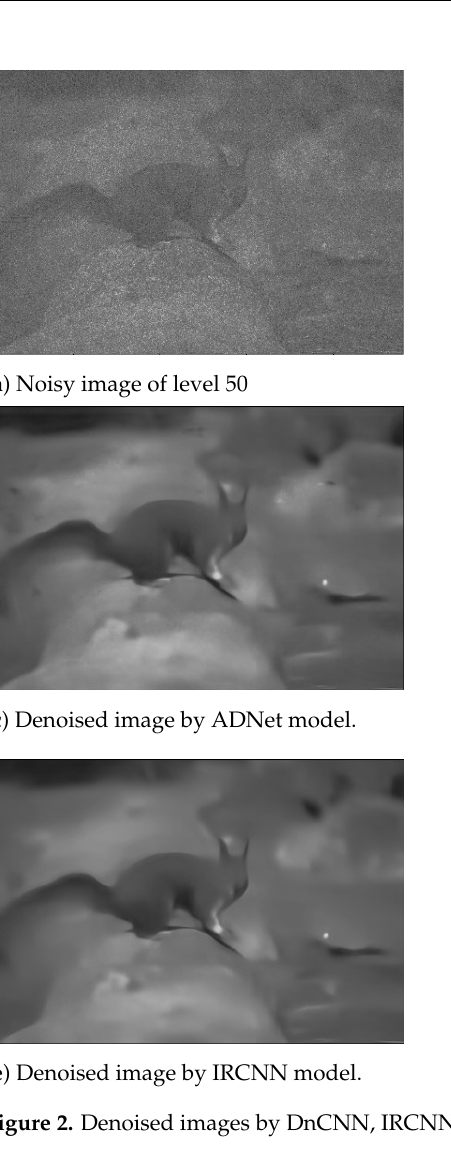
Figure 2. Denoised images by DnCNN, IRCNN, ADNet, and Proposed ensemble